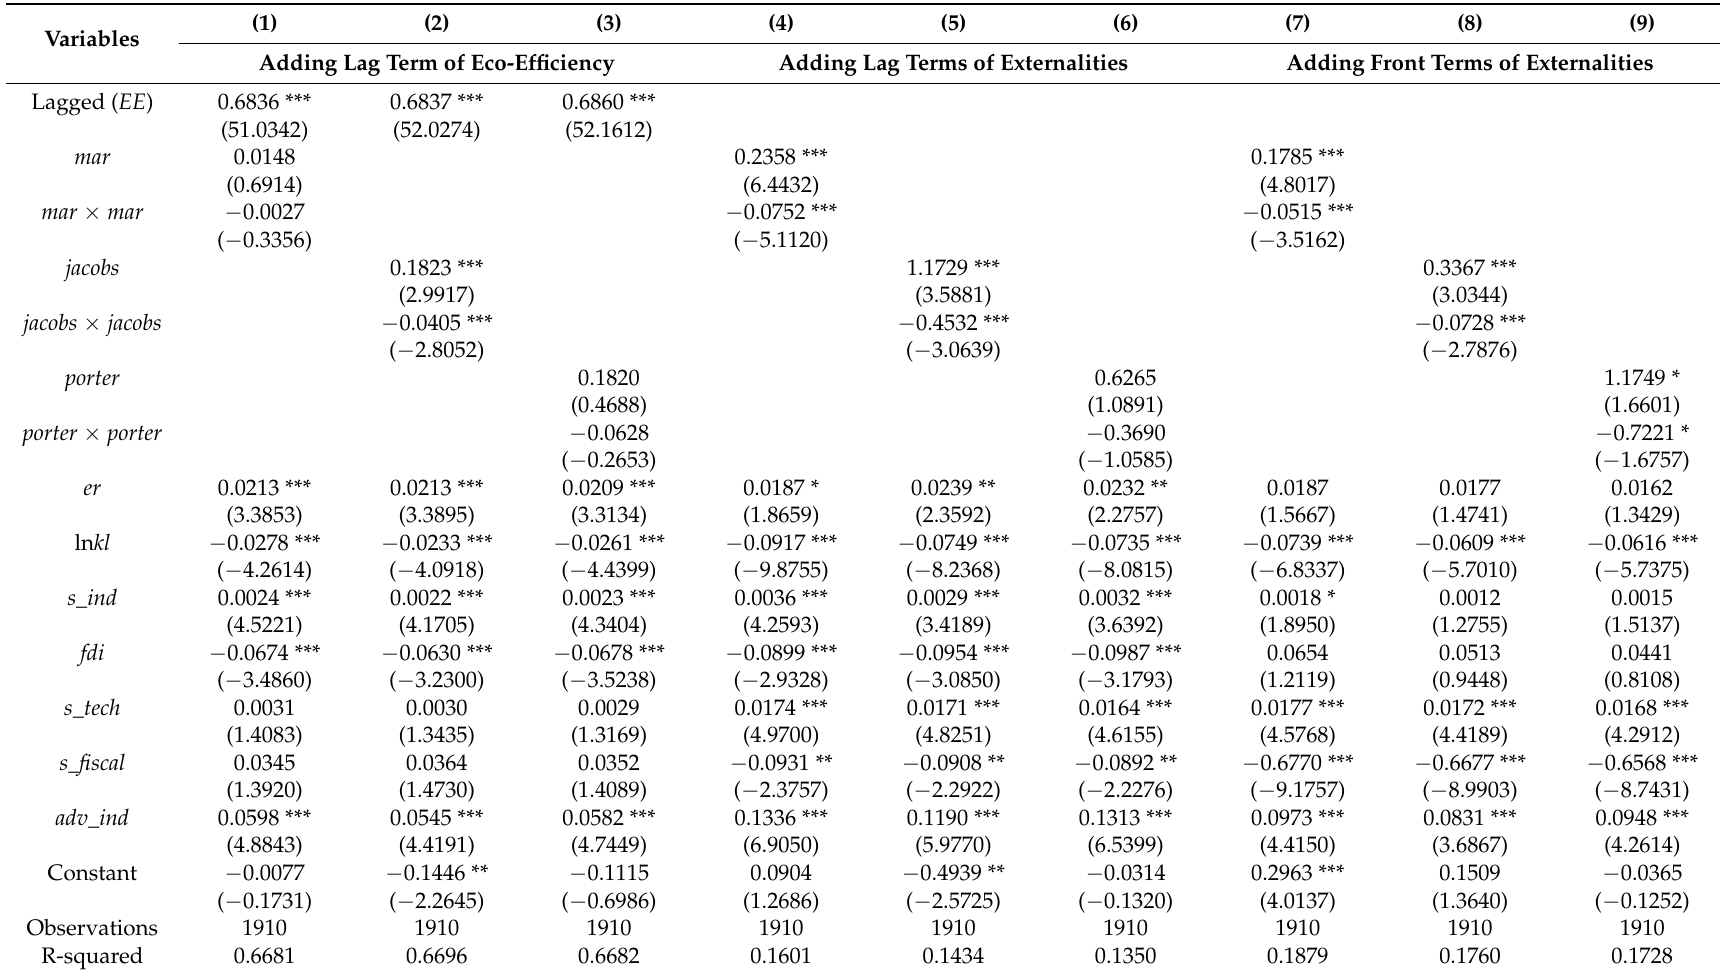
Table 9. Robustness check: dynamic effects and inverse causality